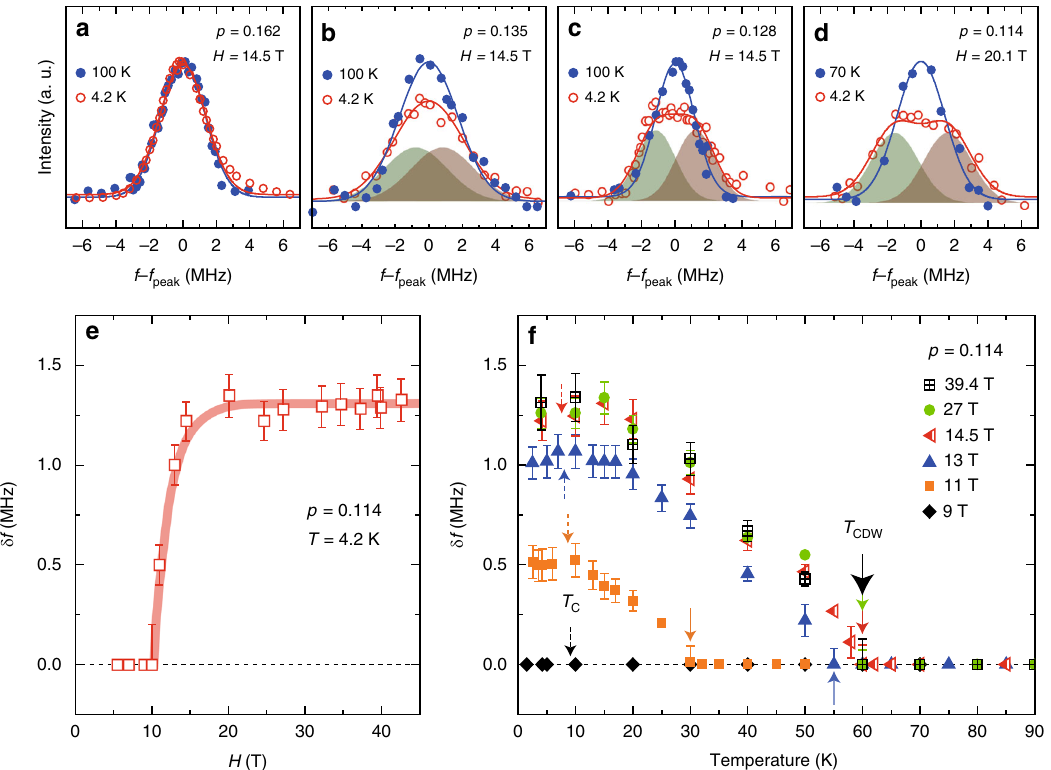
Fig. 1 Field and temperature evolution of NMR satellite line for underdoped Bi2201. a – d The NMR satellite (3/2 ↔ 1/2 transition) lines for Bi 2 Sr 2 − x La x CuO 6 x = 0.4 ( p = 0.162), x = 0.6 ( p = 0.135), x = 0.65 ( p = 0.128), and x = 0.75 ( p = 0.114). The curves for p = 0.135, 0.128, and 0.114 at T = 4.2 K are the + δ with sum of two Gaussian functions (shaded area). f peak is the peak frequency. The intensity is normalized by the area of the spectrum. e Field evolution of the line splitting δ f for p = 0.114 at T = 4.2 K. f Temperature evolution of δ f for p = 0.114 under various fi elds. The solid arrows indicate T CDW . The dotted arrows indicate T c ( H ). Error bars represent the uncertainty in estimating δ